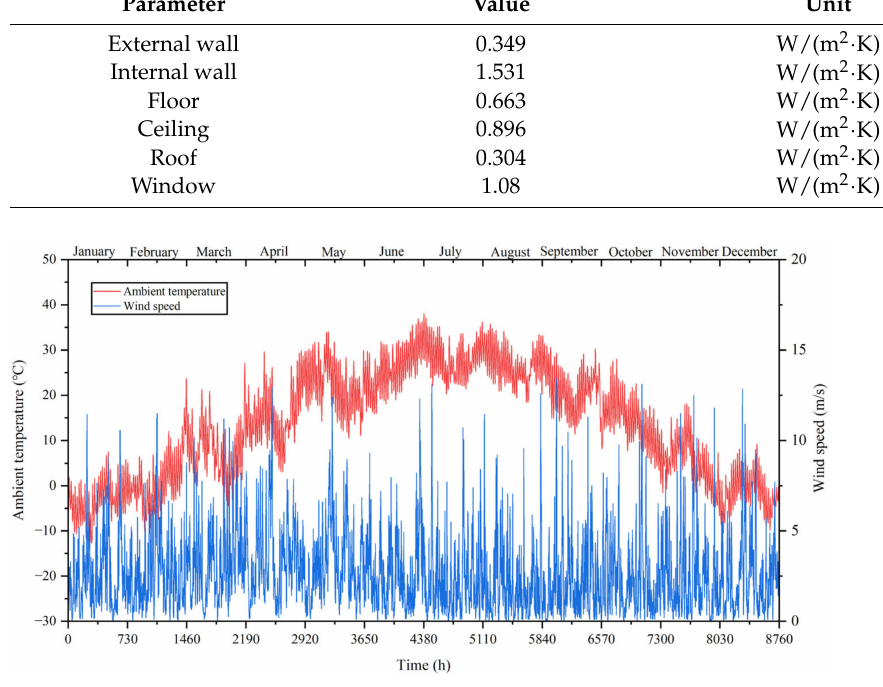
Figure 3. Hourly ambient temperature and wind speed in Tianjin, China.